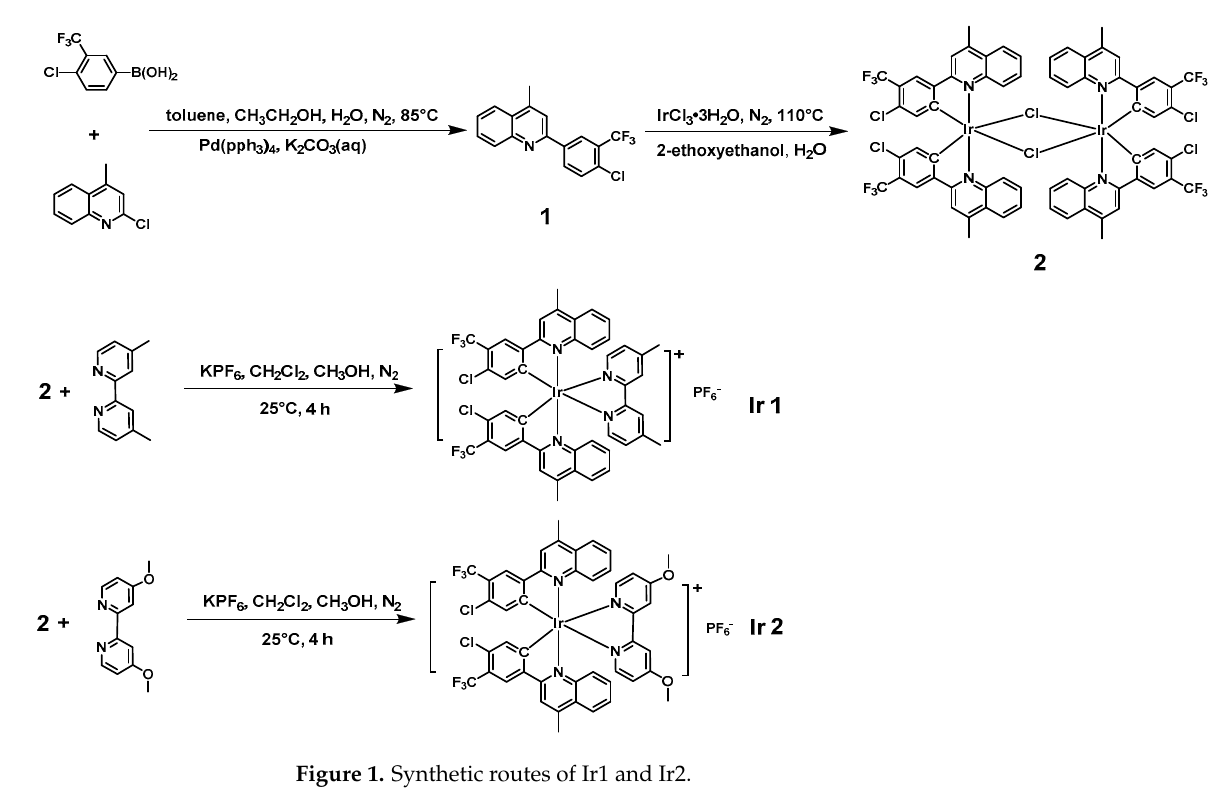
Figure 1. Synthetic routes of Ir1 and Ir2.